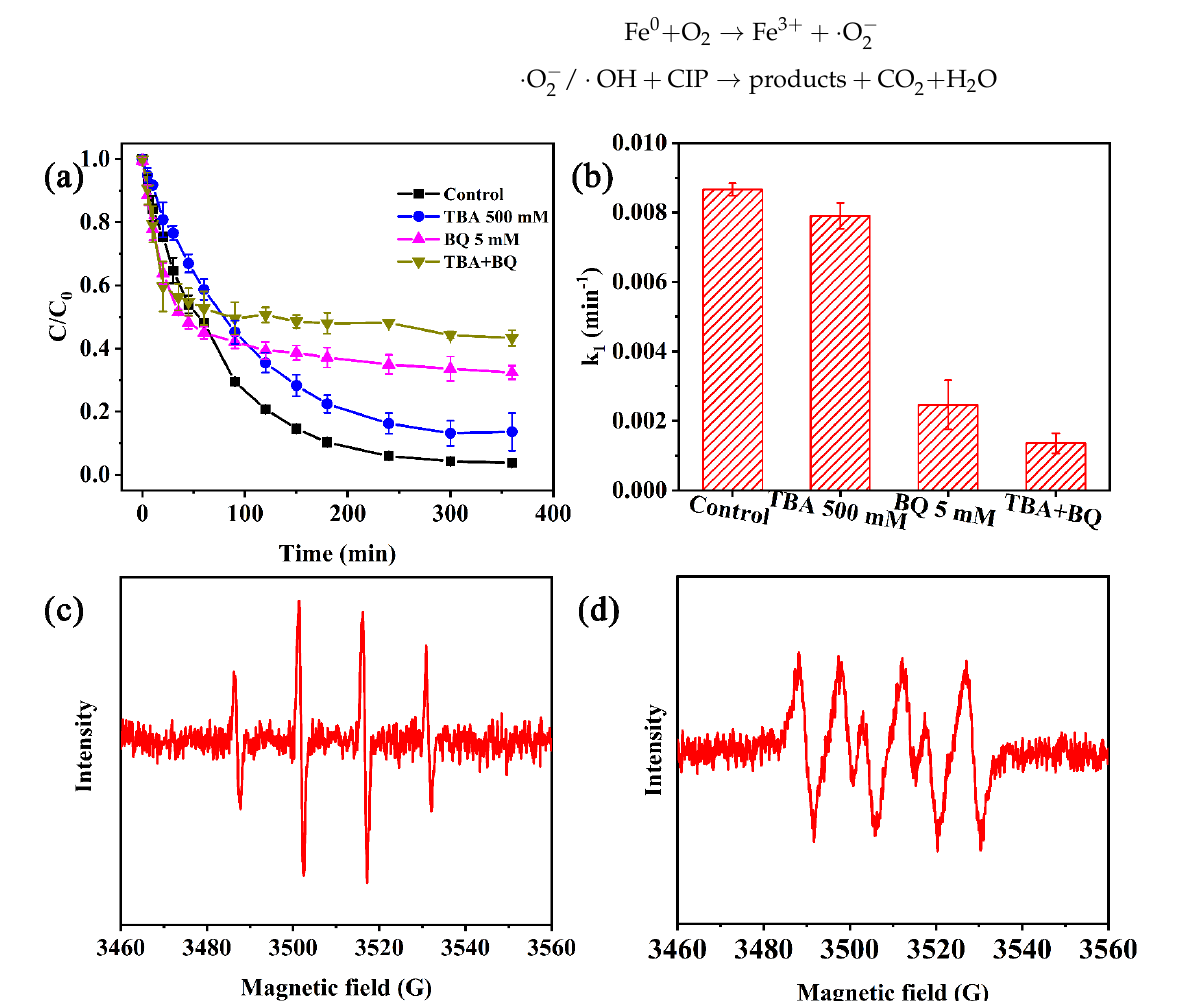
Figure 7. Inhibition effects of TBA and BQ ( a ), and k 1 value of each scavenger ( b ) on the degradation of CIP, ESR spectra of DMPO spin trapping adducts of · OH ( c ) and · O − 2